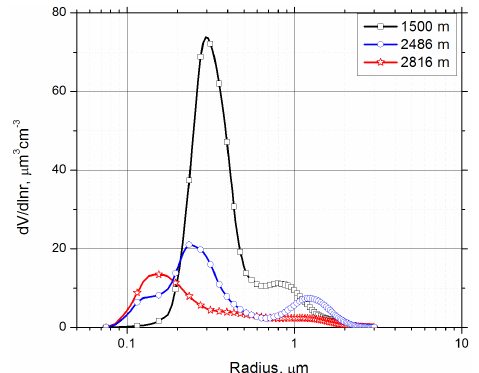
Figure 14. Particle size distributions for layers of 250m centered at 1500, 2486 and 2816m derived from lidar measurements on 28 August during